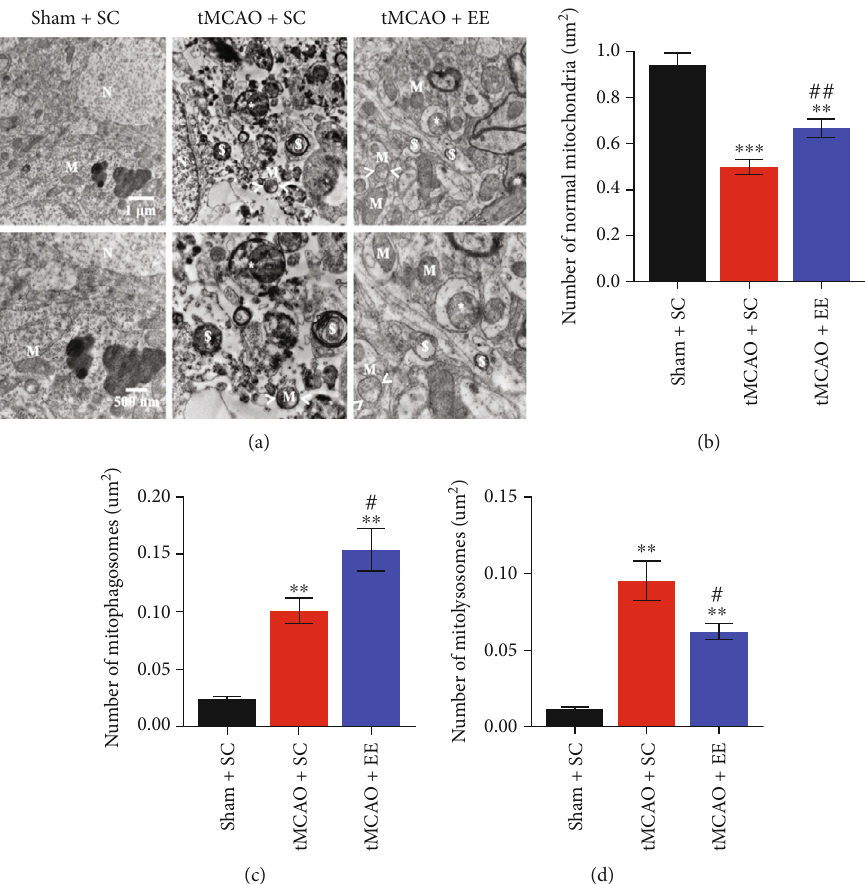
Figure 6: (a) The results of electron microscopy; N represents the nucleus, M represents normal mitochondria, > M < represents damaged mitochondria, ∗ represents mitophagosome with an evident bilayer membrane structure, and $ represents mitolysosome with monolayer membrane structure. (b) Comparison of normal mitochondria. (c) Comparison of mitophagosomes. (d) Comparison of mitolysosomes. ∗∗ P < 0 : 01 and ∗∗∗ P < 0 : 001 vs . sham+SC group; # P < 0 : 05 and ## P < 0 : 01 vs . tMCAO+SC